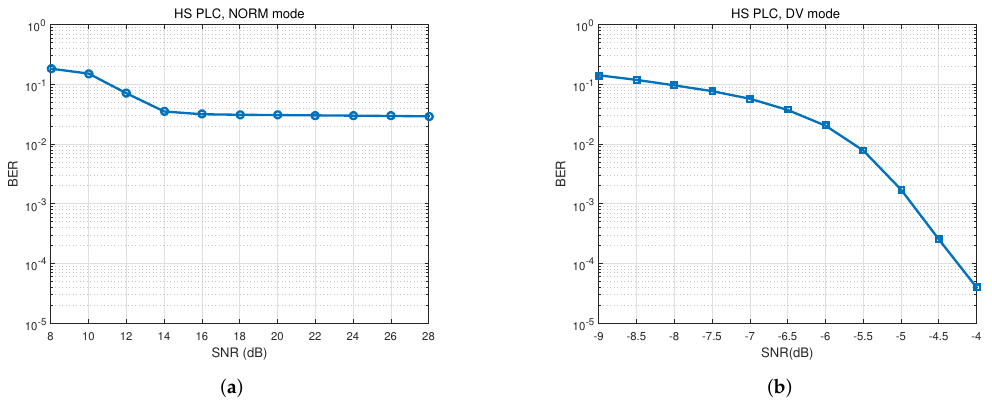
Figure 19. BER results for HS PLC: ( a ) NORMAL mode; and ( b ) DV mode.